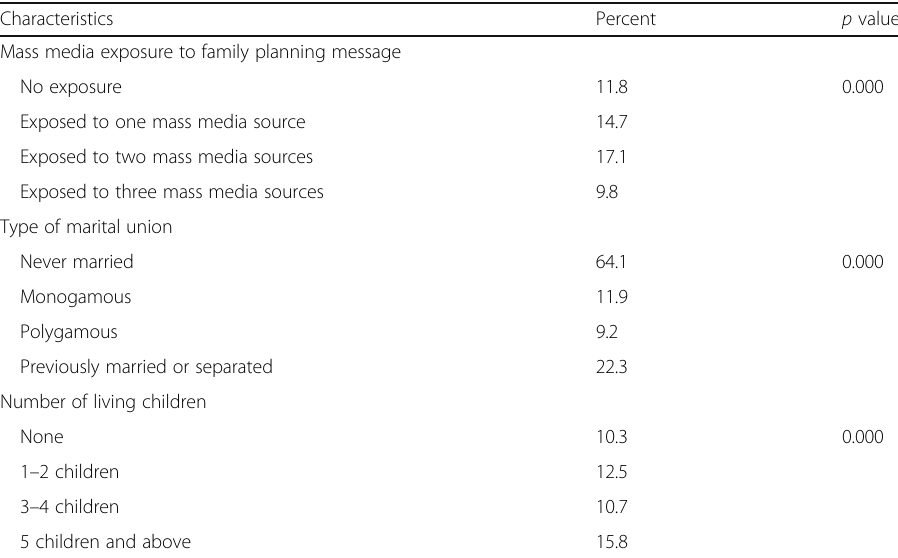
Table 2 Percent of women who experienced unintended in the past 2 years in Nigeria (NDHS 2018), N = 13,109